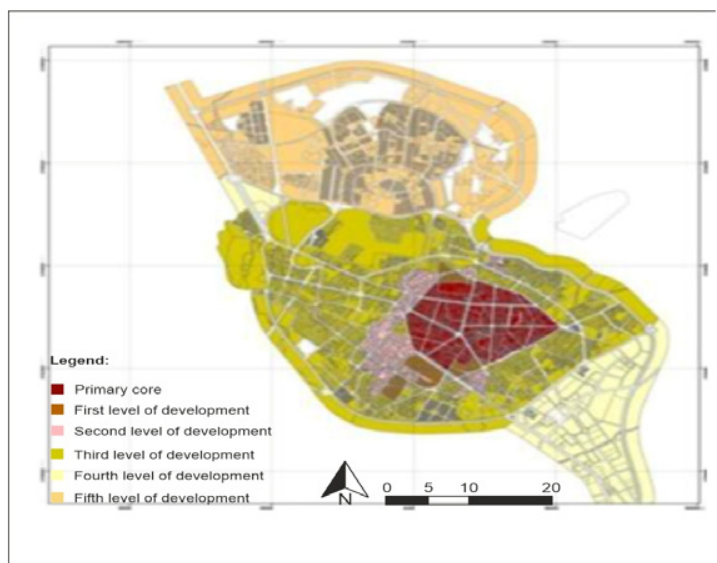
Fig.3: Development of the city in different historical stages of the city